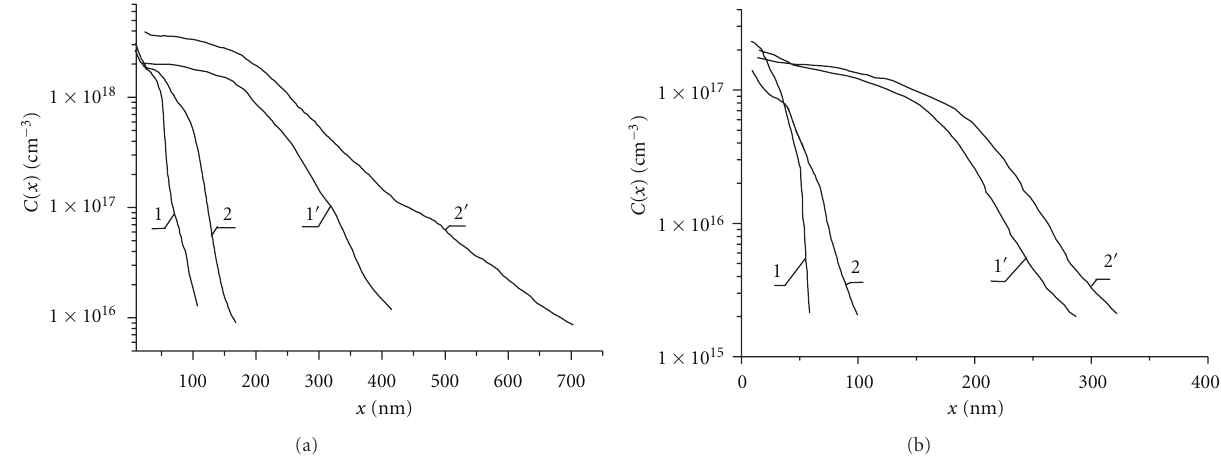
Figure 2: Experimental profiles showing erbium (a) and vanadium (b) concentration versus depth after di ff usion at 2200 ◦ C for 30 min (curves 1 and 2) and 120 min (curves 1 (cid:6) and 2 (cid:6) ), in: 1: nonporous SiC, 2: porous